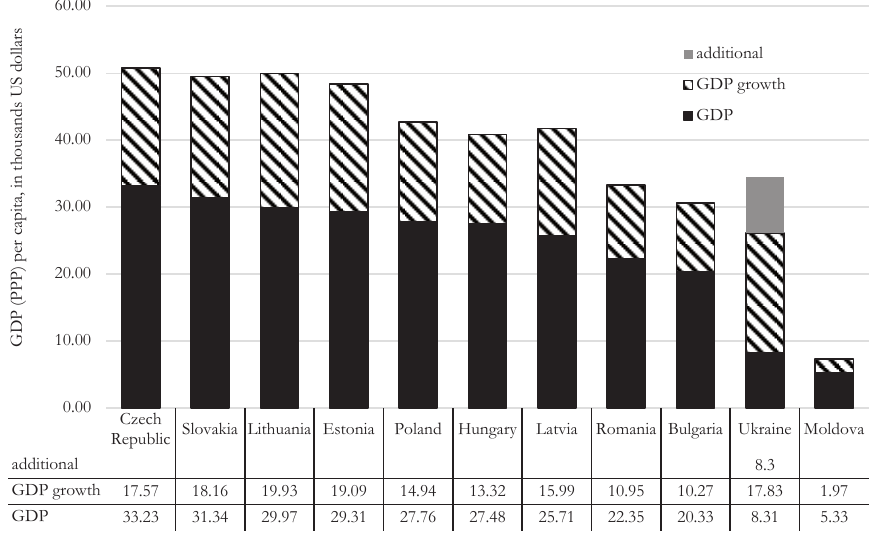
Fig. 15 – The forecast of growth of GDP (PPP) for Eastern European countries in 2034. Source: own